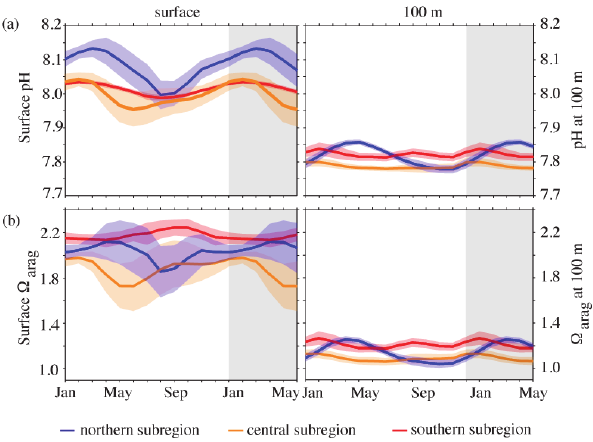
Fig. 8. Seasonal cycle of (a) pH and (b) (cid:127) arag in the nearshore 50km. The lines represent the mean and the shaded area the spatial variability ( ± 1STD) for each month, for the northern (blue), central (orange) and southern (red) subregions, at the surface (left) and at 100m (right). The shaded area depicts the first six months of the following annual